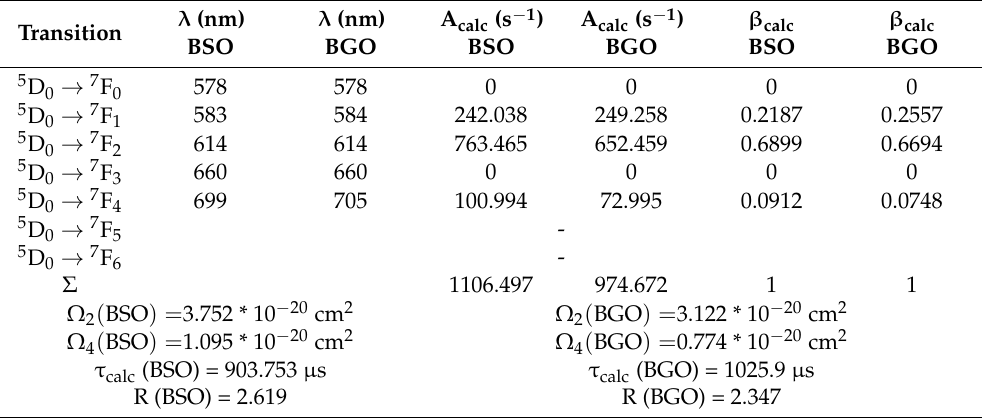
Table 1. The spontaneous emission probabilities (A), radiative lifetimes ( τ ), fluorescence branching ratios ( β ), and asymmetry ratios (R) of BSO and BGO calculated using the obtained Judd–Ofelt parameters ( Ω ).